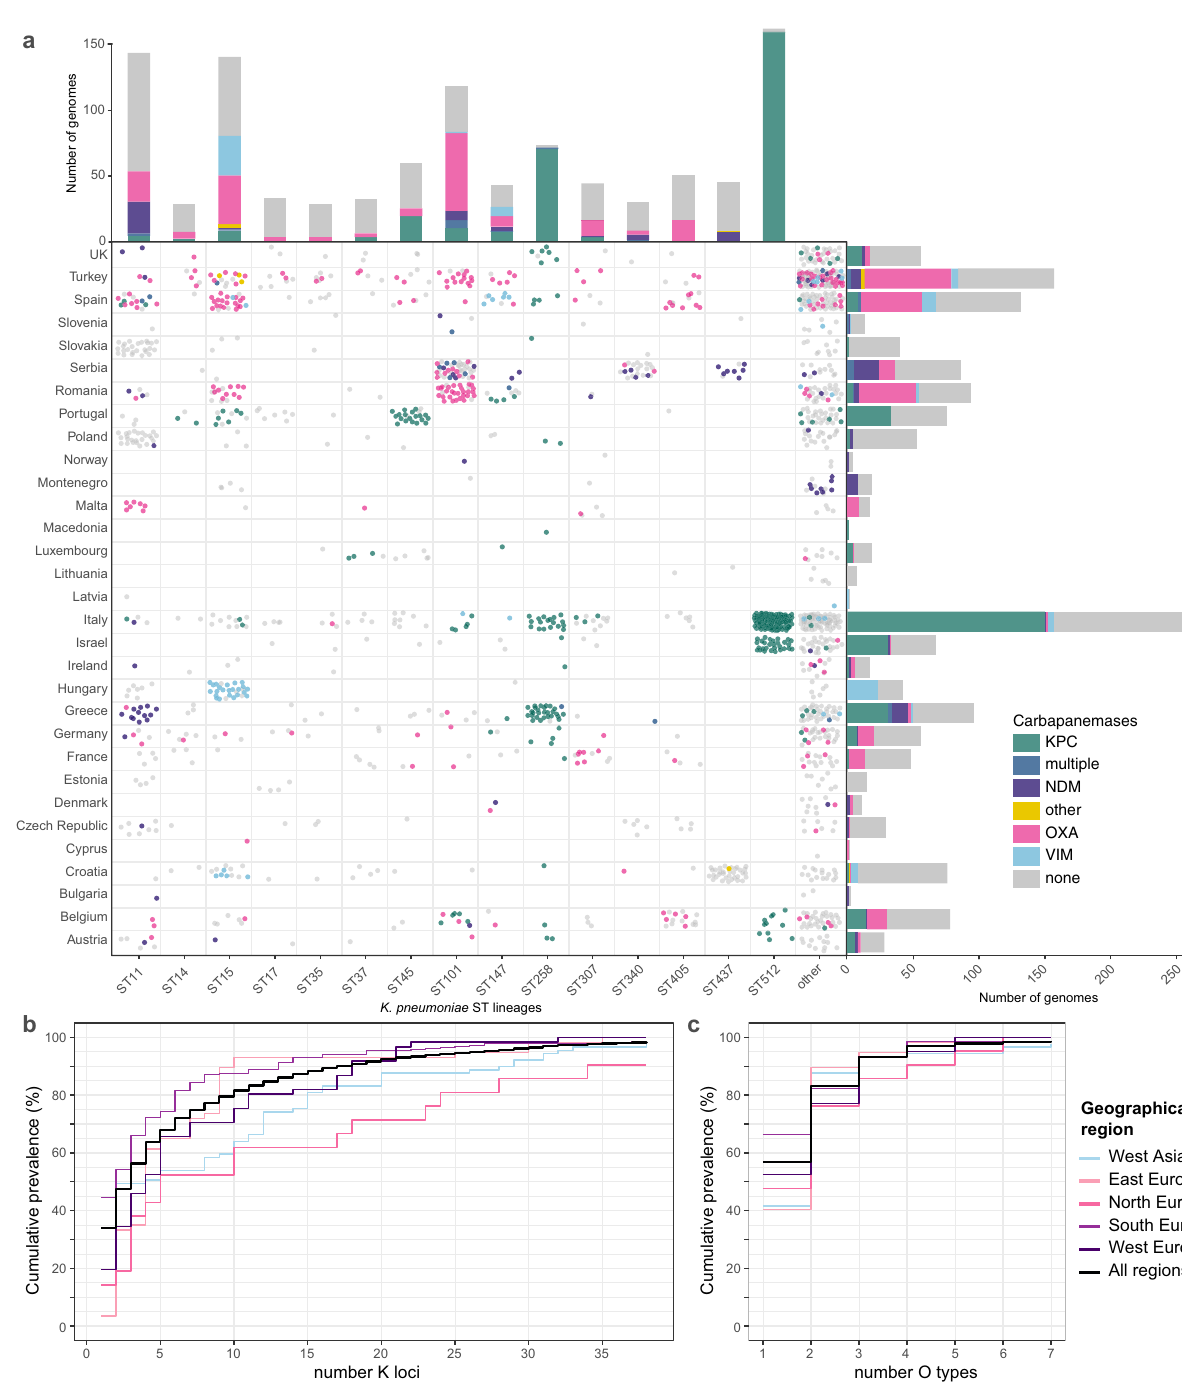
Fig. 2 Kleborate genotyping results for European K. pneumoniae surveillance isolates. Data shown summarize Kleborate results for 927 carbapenem- non-susceptible and 697 carbapenem-susceptible K. pneumoniae genomes from the EuSCAPE study (data included in Supplementary Data 2). a Geographical and lineage distribution of carbapenemase genes. Each circle represents a genome, coloured by carbapenemase (see inset legend). Barplots summarize the number of genomes from each K. pneumoniae lineage (top) and country (right), coloured by carbapenemase. b – c Cumulative prevalence of ( b ) capsule (K) locus and ( c ) O antigen locus types, for carbapenem-non-susceptible (meropenem MIC> 2) isolates, ordered by overall prevalence. Thick line indicates curve for whole data set; others give results separately for different United Nations geographical regions (see inset